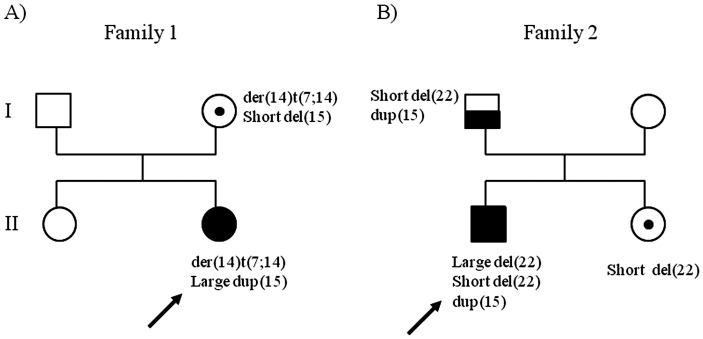
Pedigrees of families with inherited deletions/duplications.(A) Pedigree of Family 1. The proposita (II, 2) carried an unbalanced 7/14 translocation and a de novo large 15q21.2q22.2 (10.5 Mb) duplication. The mother (I, 2) carried the same unbalanced 7/14 translocation and a BP4–BP5 15q13.2q13.3 deletion of 2.262 Mb (short deletion). B) Pedigree of Family 2.The propositus (II, 1) had two deletions on the same chromosome 22: a short 22q11.23 (247 Kb) deletion inherited from his father and one de novo large deletion 22q11.21 (1.417 Mb). He also showed a duplication of 484.3 Kb at 15q26.3 inherited from his father. His normal sister (II, 2) carried only the short deletion 22q11.23. Their father (I, 1) had both the short deletion of chromosome 22 and the duplication of chromosome 15.